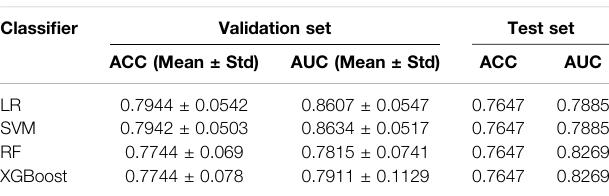
TABLE 2 | ACC and AUC of individual